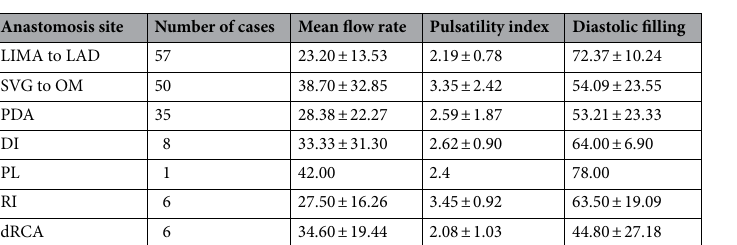
Table 2. The values of the TTFM parameters for each anastomosis site. LIMA left internal mammary artery, LAD left anterior descending artery, OM obtuse marginal branch artery, PDA posterior descending artery, DI diagonal artery, PL posterolateral artery, RI ramus intermedius artery, dRCA distal right coronary artery.